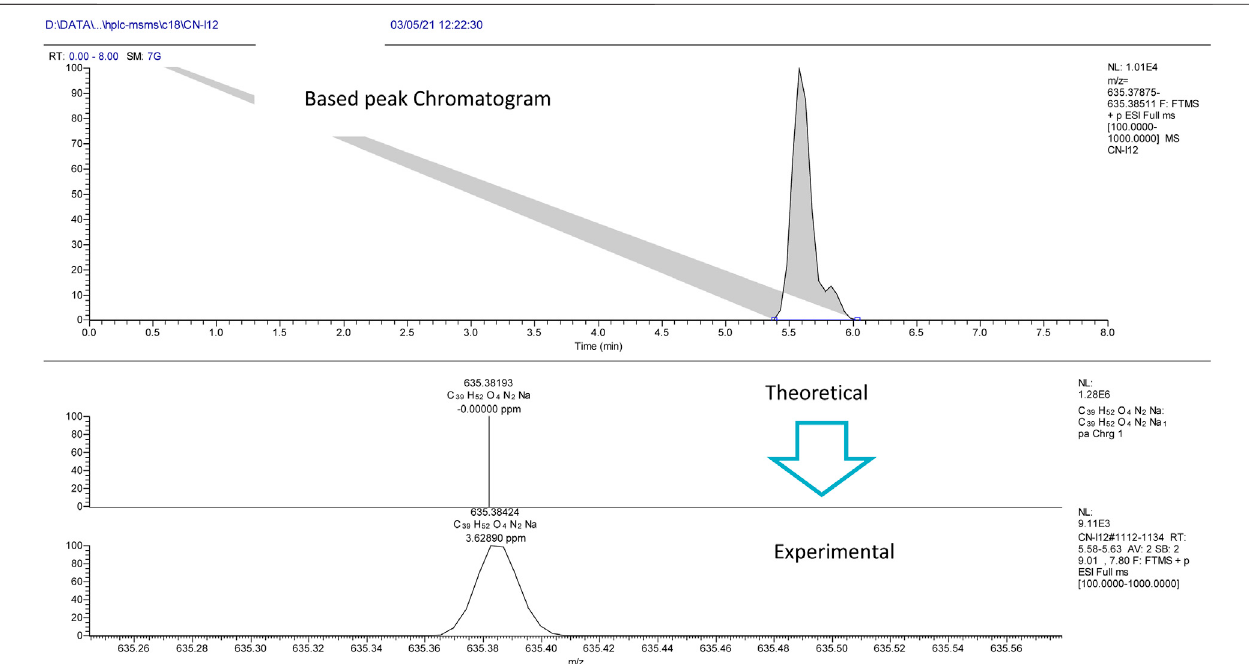
Frontiers in Chemistry |